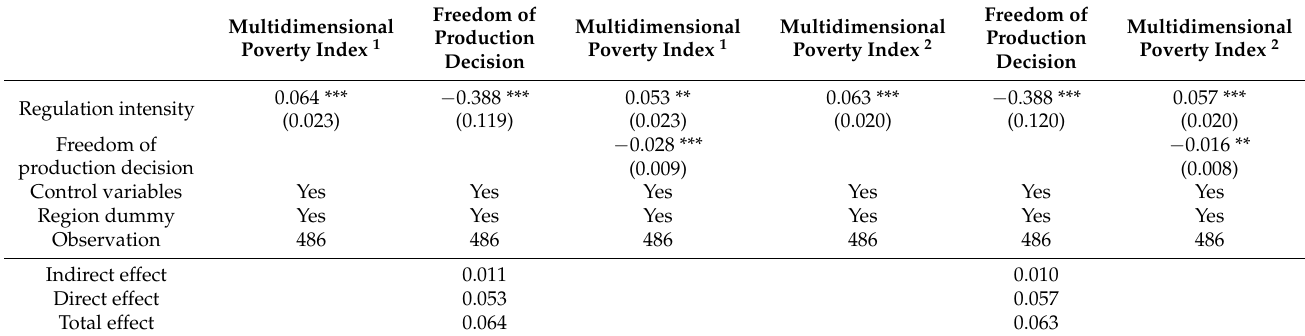
Table 11. Regulation in nature reserves vs. multidimensional poverty index of farmers (using new main independent